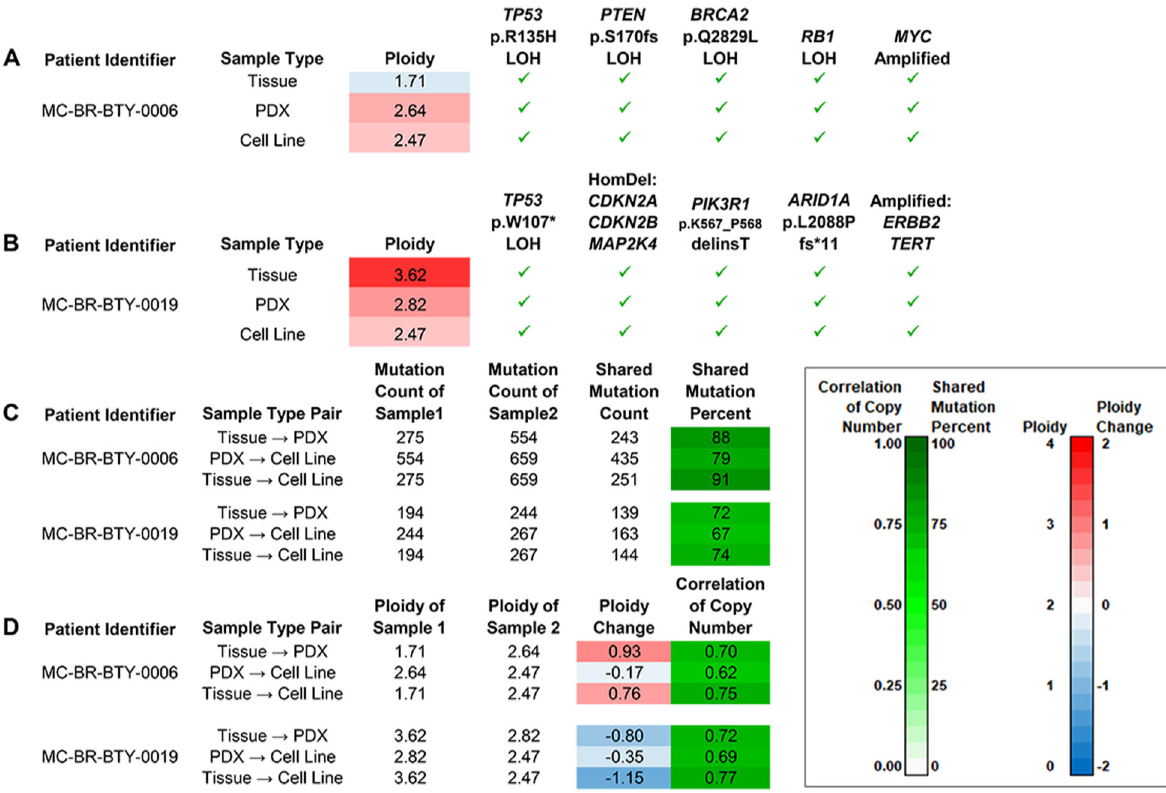
Fig. 5 Exome sequencing reveals several patient-speci fi c cancer driver mutations and an evolutionary trajectory that features their preservation in the presence of somatic changes suggestive of genome instability. A Oncogenic mutations in fi ve cancer genes were detected in all three MC-BR-BTY-0006 tumor samples. Pathogenic loss-of-function somatic SNVs were detected in one allele of each of the genes TP53, PTEN, and BRCA2 as well as the other allele (loss of heterozygosity, or LOH). Thus, loss of function of both copies of tumor- suppressor genes TP53, PTEN, and BRCA2 could be inferred. RB1 loss of heterozygosity (LOH) and ampli fi cation of MYC were other oncogenic events observed. B Oncogenic mutations in eight cancer genes were detected in all three MC-BR-BTY-0019 tumor samples. A different pathogenic loss-of-function mutation in TP53 for cell line, but was again observed alongside LOH. So, loss of function of both copies can be inferred for TP53 as well as for three other tumor suppressor genes, CDKN2A, the adjacent CDKN2B, and MAP2K4, due to homozygous deletion (HomDel). Mutations were also observed in PIK3R1 and ARID1A. The mutations affect sites in regions frequently altered in cancer. Ampli fi cations of TERT and ERBB2, or HER2, were also detected, with particularly high ampli fi cation for ERBB2. C Of the somatic SNV/INDELs detected in the patient tumor tissue samples, proportions detected in PDXs and cell lines were high ( ≥ 72%) for both patients. Of those mutations detected in PDXs, proportions detected in cell lines were also high (79%, 67%). D Changes in ploidy by sample type pair. For each patient, the absolute differences were nearly 1 copy from tissue to PDX with a Tissue → PDX increase observed for MC-BR-BTY-0006 and a Tissue → PDX decrease observed for MC-BR-BTY-0019. Despite these changes, the pro fi les of within-sample relative copy numbers for Tissue and PDX still showed similarity as the correlation of copy number was still 0.70 or greater. Slight decreases in ploidy were observed from PDX to cell line for both (Fig. 4D). As for triple-negative breast cancer in vivo models, MDA- MB-468 and MDA-MB-231 are the most commonly used cell lines 20 . Our established MC-BR-BTY-0006 cell line can form CDX tumors after 3 weeks, further increasing the pool of available triple-negative cell lines that can form CDX tumors in vivo. The CDX took a shorter time period to form a measurable tumor after implantation compared to PDX and had a much faster tumor growth rate once it reached a volume of 500 mm 3 . Since this study primarily focused on demonstrating the feasibility of establishing PDX-derived breast cancer cell lines and the basic characteristics of these cell lines, we only tested the most commonly used drugs in HER2 + and triple-negative breast cancer cells — lapatinib and paclitaxel, respectively. Despite some observed differences in pathology between the CDX and PDX tumors, their response to drug treatment remained consistent (Fig. 4). In future studies, it would be interesting to test a wider panel of drugs for these two cell lines to further extend the applications of these two cell lines in drug screening and understanding drug mechanisms of action.